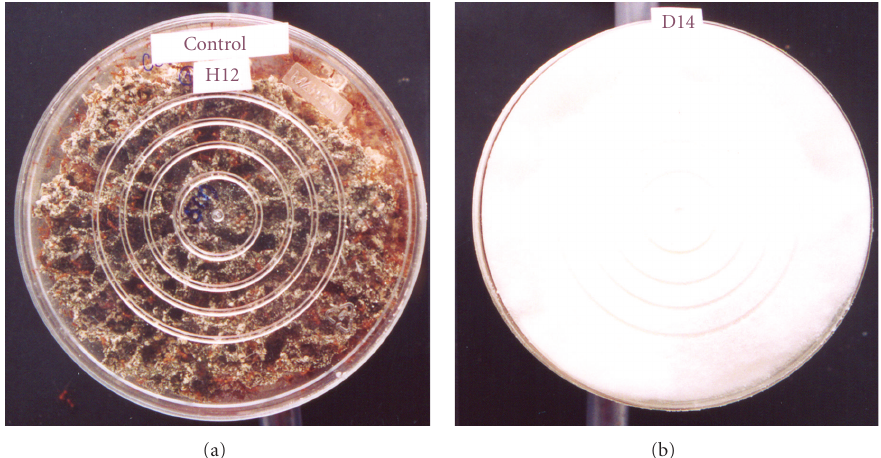
Figure 2: Laboratory colonies of Atta sexdens rubropilosa (Corumbata´ı, Brazil). Colonies were treated with baits without insecticide, control (a) and formulated baits containing the insecticide Hydramethylnon (b). Escovopsis sp. (white mycelia) emerged two days after treatment from fungus gardens of the infected colony (b), which depicts the aggressive e ff ect of such parasite on attine ant